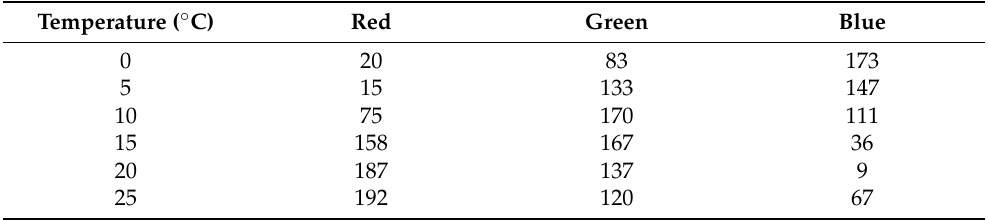
Table 1. Color responses of the HPC colorimetric sensor as a function of temperature calculated in RGB color